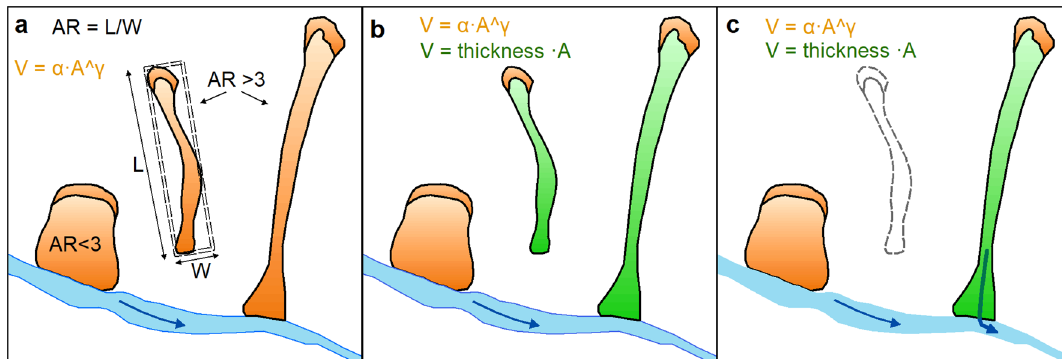
Figure 7. Schematic representation of the three methods for volume calculation. ( a ) V_ALL: Larsen et al. 36 relationship was applied to the entire landslide area with the two parameterizations (R1 and R2) 36 . ( b ) V_AR: Larsen et al. 36 for landslides with AR < 3, and for scar area of landslide with AR > 3; for the runout of